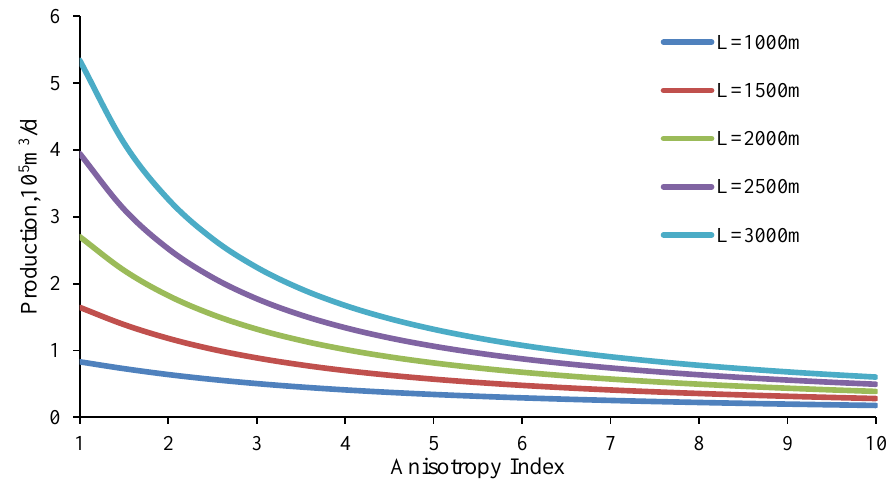
Figure 8—Effect of the anisotropy index on production at different horizontal well length Eccentric distance. The influence of the eccentric distance ( 𝛿 ) on production was investigated versus various horizontal well length. The anisotropy index ( I ), was set to be 1. Figure 9 shows that the larger ani the eccentricity distance, the smaller the production, and the degree of influence gradually decreases. The longer the horizontal well is, the more impact of eccentricity distance on productivity.